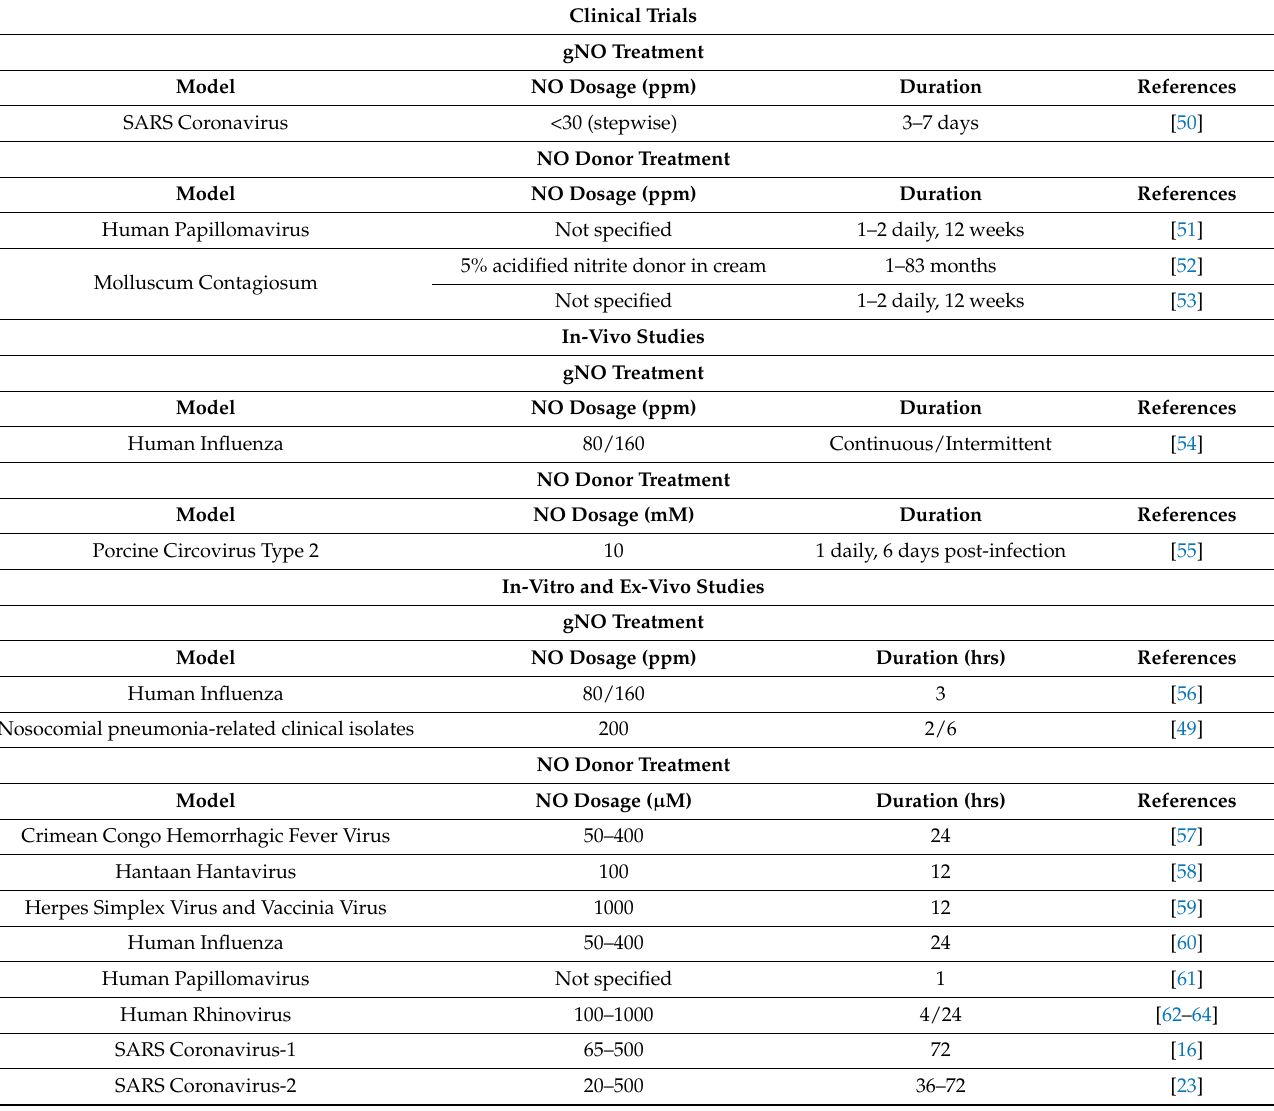
Table 1. Summaries of the studies on gNO and NO-donors as antiviral